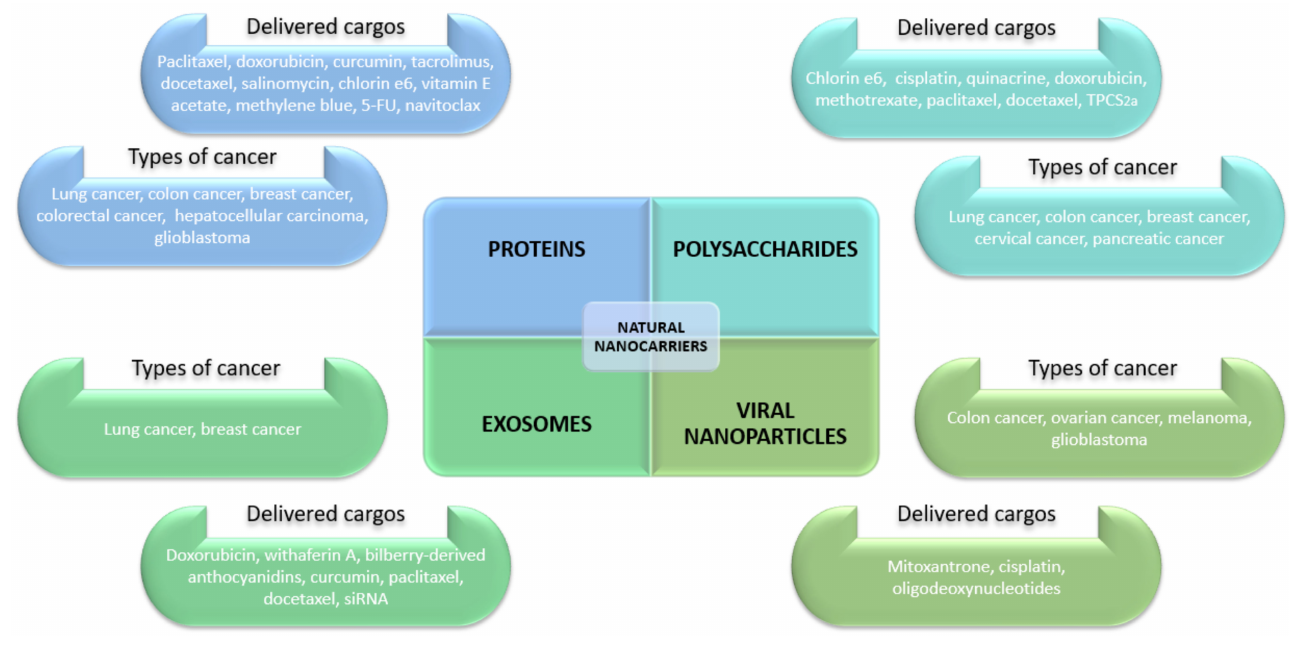
Figure 7. Overview of the main discussed categories of natural nanocarriers for cancer